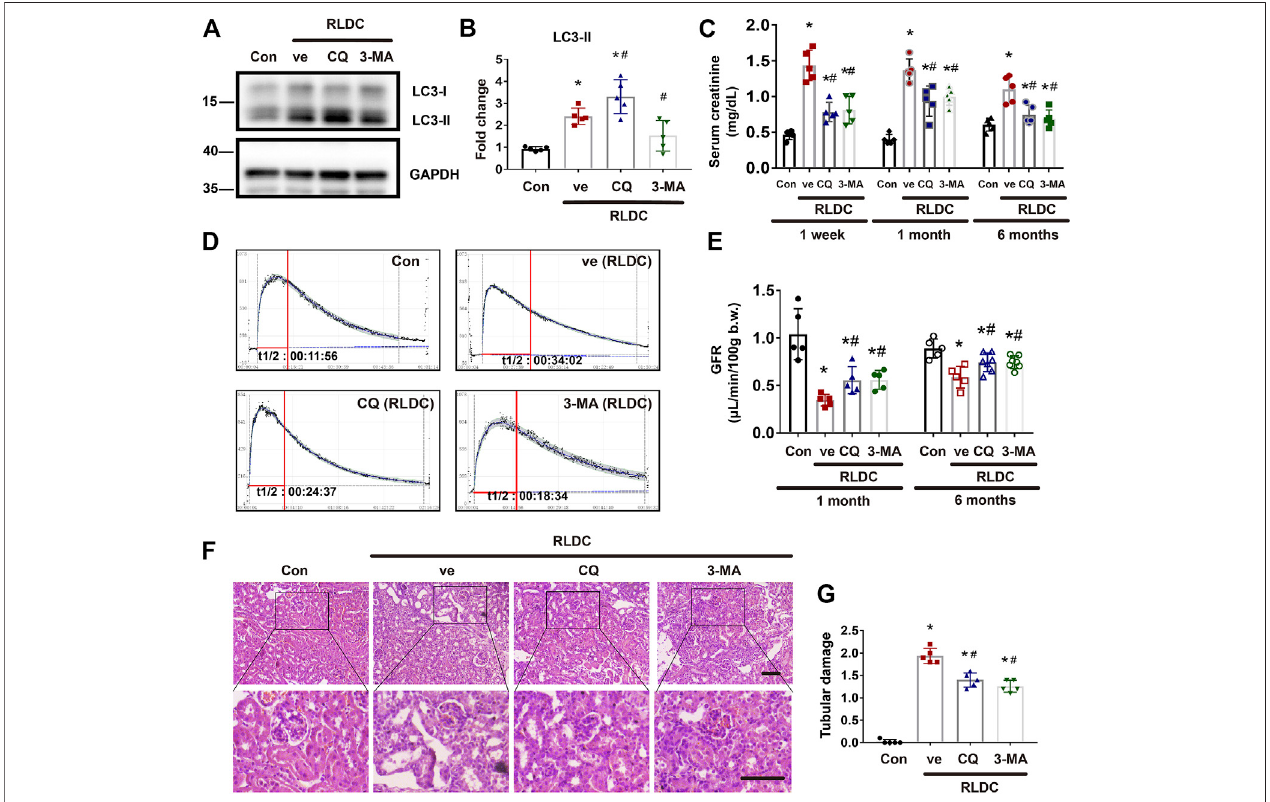
FIGURE 2 | Pharmacologic inhibition of autophagy alleviates renal dysfunction and tubular damage in post-RLDC kidneys. Male C57BL/6 mice were injected weekly with 8 mg/kg cisplatin for 4 weeks (RLDC) or with saline as control (Con). After the fi nal dose, the mice were injected with 60 mg/kg/day chloroquine (CQ), 20 mg/kg/day 3-methyladenine (3-MA), or saline as vehicle solution (ve) for 7 days. (A) Representative immunoblots of LC3-I, LC3-II and GAPDH (loading control) in kidney tissues ( n = 5). (B) Densitometry of LC3II. The experiments were normalized according to GAPDH expression. The protein level of control group (Con) was arbitrarily set as 1, and the signals of other conditions were normalized with the control group to indicate their protein fold changes. (C) Effect of autophagy inhibitor on serum creatinine at 1 week, 1 month and 6 months after RLDC treatment. ( n = 5). (D) Representative tracing curves of FITC-sinistrin clearance in mice. ( n = 5). (E) GFR measurementbytranscutaneouslymonitoringFITC-sinistrinclearance( n =5). (F) Representativehistologyimagesofhematoxylin-eosinstainingofkidneytissuesinrenal cortexandoutermedulla.( n =5,bar=50 μ m). (G) Pathologicalscoreoftubulardamage.Quantitativedataareexpressedasmean±SEM.* p < 0.05vsthecontrolgroup (Con), # p < 0.05 vs. (RLDC + vehicle)